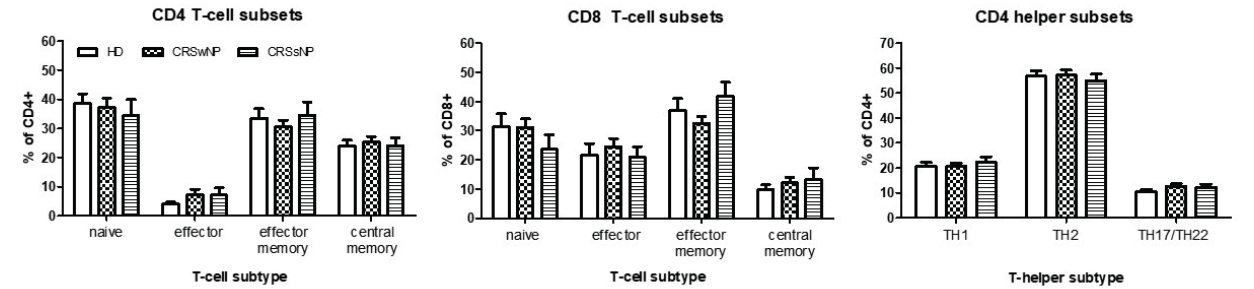
Figure 2. Flow cytometric analysis of CD4+ and CD8+ T-cell subset distribution in PBMC from CRSwNP (n = 38) and CRSsNP (n = 14) patients com- pared to healthy donors (n = 21). Percentages of naïve, effector, effector memory and central memory T cells within CD4+ or CD8+ T cells as well as of CD4+ T helper cell subsets TH1, TH2 or TH17/22 are